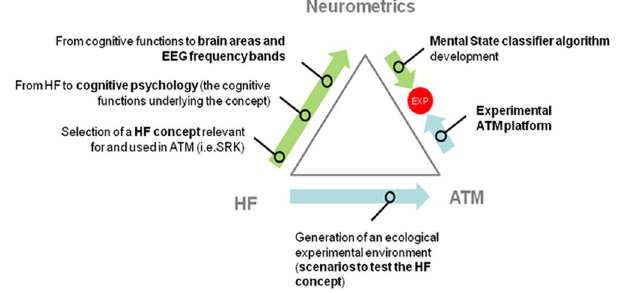
Figure 1. Simplified illustration of the multi-disciplinary approach used in the study. Three levels of analysis have been considered: human factor concepts, realism of the experimental task, and neurophysiological evidences related to the main cognitive phenomena linked to the SRK